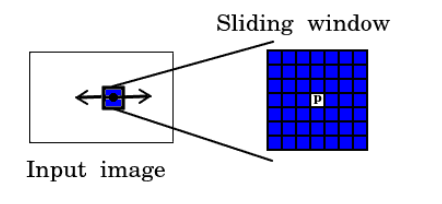
Figure 8. The sliding windows form the neighborhood of the pixel P .